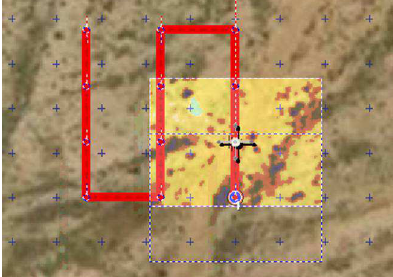
Figure 2. Flight planning with a parallel lines route and a total of twelve